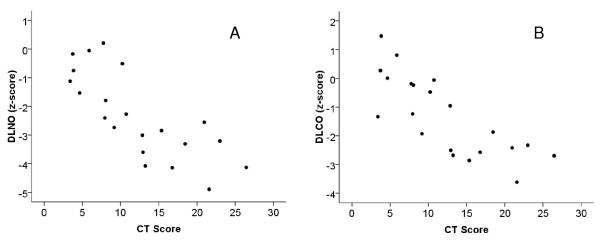
Scatterplots for z-scores of DLNO (Panel A, rS = -0.83; p < 0.001), and DLCO (panel B, rS = -0.79; p < 0.001) against total CT score.